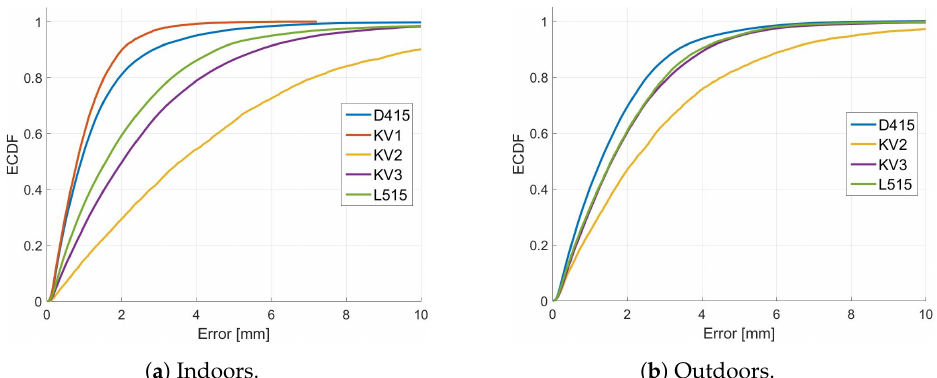
Figure 14. Plots comparing ECDF plots for scans of two different unpainted grape bunches which were captured by depth cameras ( a ) indoors and ( b ) outdoors in direct sunlight using ICP alignment of the depth camera scans with the photogrammetry scans. The grapes were located 600 mm from the cameras. Table 3. Estimate of the percentage of the depth scan that is missing for each camera relative to that obtained using the photogrammetry